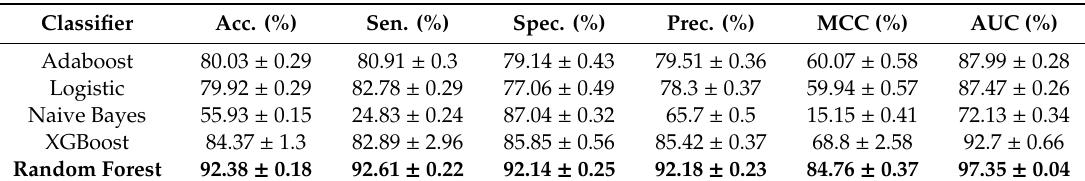
Table 5. Comparison of di ff erent classifiers.